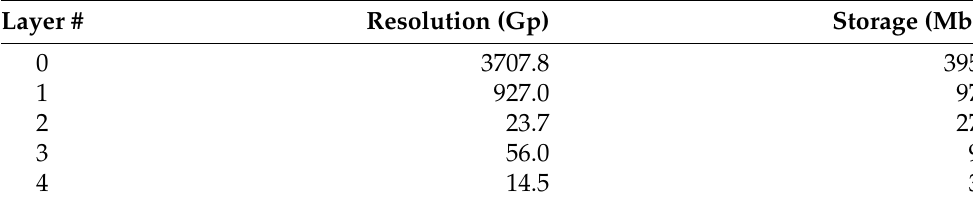
Table 5. Mosaic resolution and storage capacity in JPEG